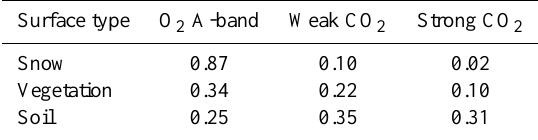
Table 2. Lambertian surface albedos, in each of the three OCO-2 spectral bands, for the three surface